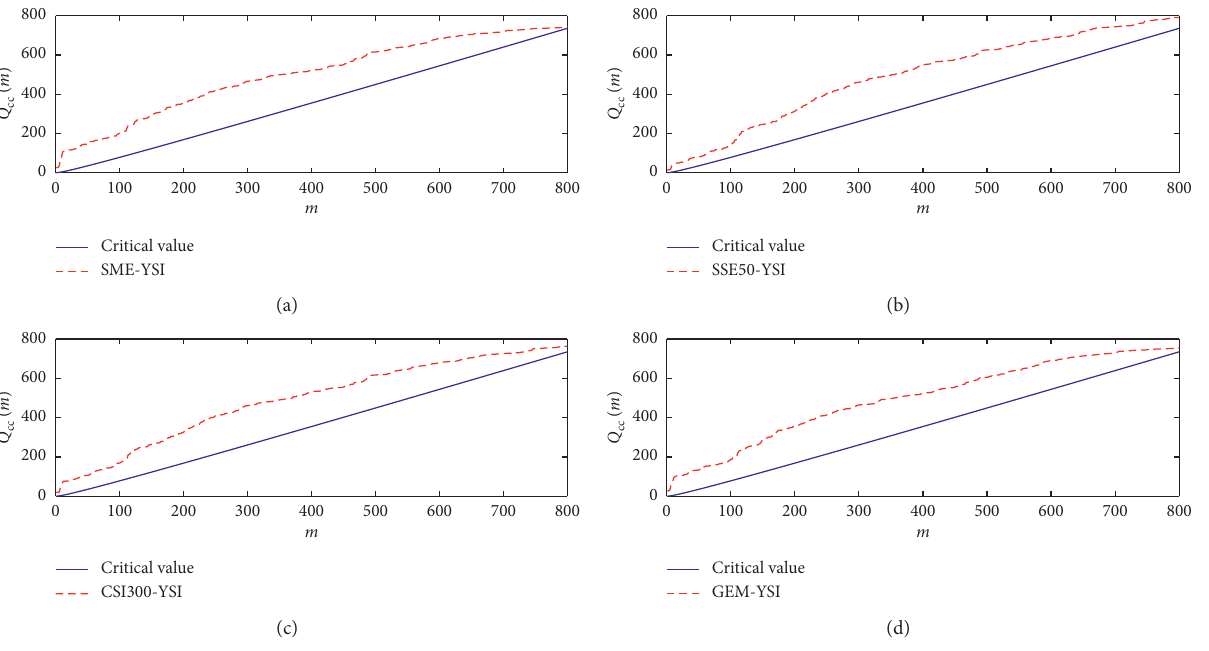
( m ) for market participation willingness and Chinese stock market returns. cc